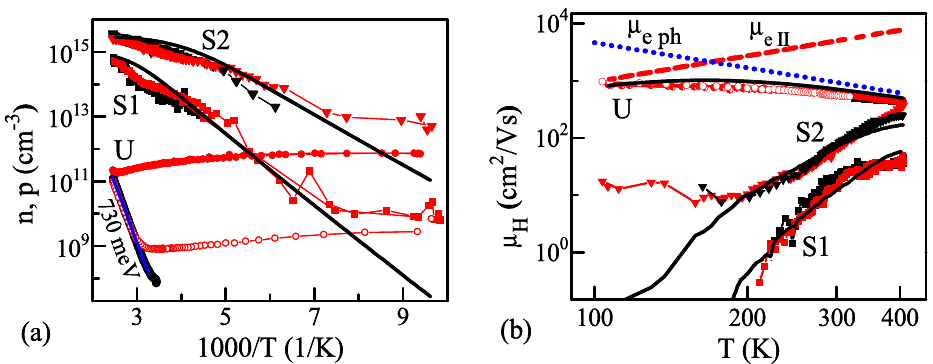
Figure 2. Temperature-dependent carrier density ( a ) and (photo)Hall mobility ( b ). Data are shown as circles for crystal U, as squares for crystal S1, and as triangles for crystal S2. Black symbols indicate measurements in the dark, while red symbols indicate photoconductivity ( a ) and photo-Hall ( b ) data measured using 850 nm excitation. For filled red symbols, excitation power density was 0.5 mW/cm 2 . For open red circles (sample U), excitation power was 0.6 µ W/cm 2 in ( a ) and 60 µW/cm 2 in ( b ). Solid lines in ( a ) are electron (U) and hole (S1, S2) density activation fits. Solid black lines in ( b ) are electron (U) and hole (S1 and S2) mobility fits. Dotted and dashed lines in ( b ) show phonon and ionized impurity scattering contributions to electron mobilities for crystal